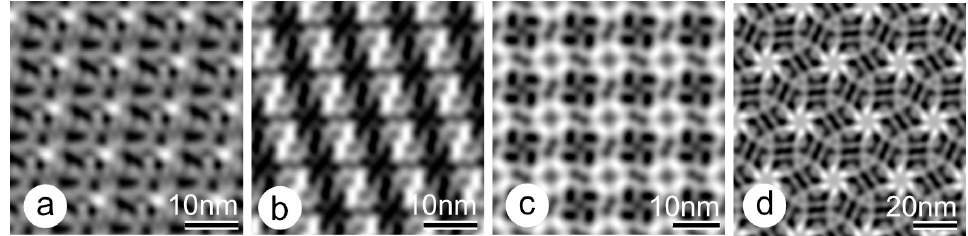
Figure 7. TEM images of negatively stained preparations of S-layer lattices with different lattice symmetries. ( a ) SbsB from G. stearothermophilus PV72/p2 with oblique (p1) lattice symmetry, ( b ) SgsE from G. stearothermophilus NRS 2004/3a with oblique (p2) lattice symmetry (reproduced with permission from Reference [23]; published by Elsevier, 1986), ( c ) SbpA from L. sphaericus CCM2177 with square (p4) lattice symmetry (reproduced with permission from Reference [46]; published by Elsevier, 1994), and ( d ) the S-layer protein of the archaeon Th. tenax with hexagonal (p6) lattice symmetry (reproduced with permission from Reference [69]; published by the American Society for Microbiology, 1986). Protein is bright, while the staining in the pores and wells is dark.